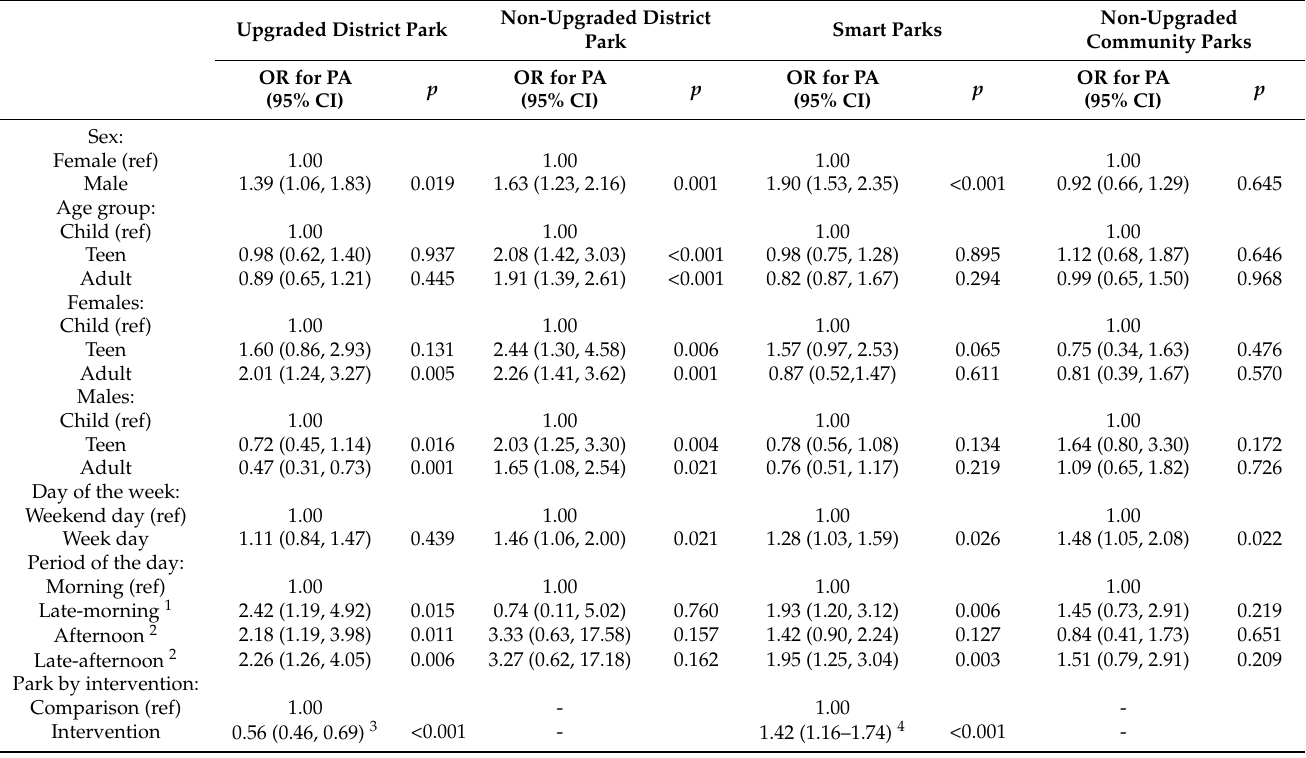
Table 5. Odds ratios for associations between observed park visitation characteristics and PA between intervention and comparison